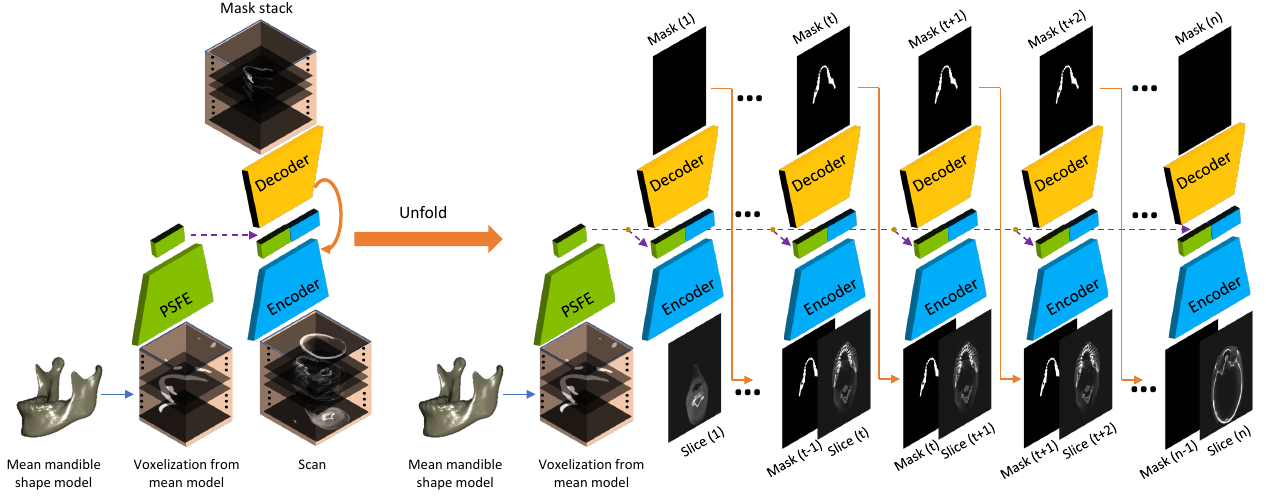
Figure 3. Overview of the proposed SASeg and its corresponding unfolded computational graph. The PSFE module is leveraged to extract general shape features from a mean mandible shape, and recurrent SegUnet connections are used to conduct the slice-by-slice